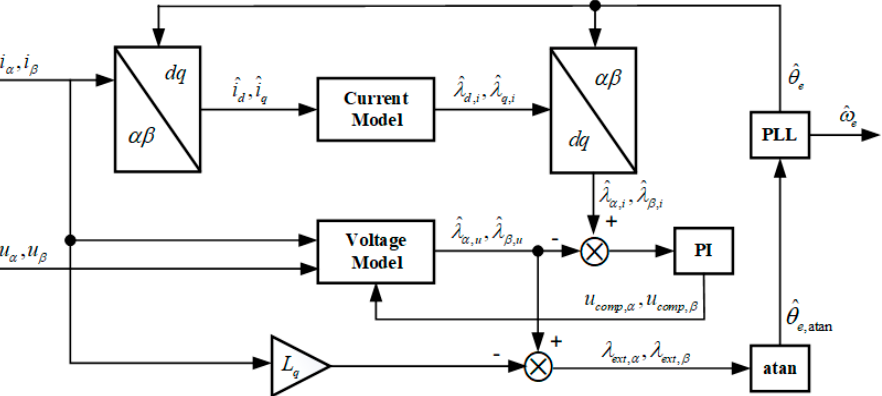
Figure 2. Structure of the extended flux-based rotor position observer.